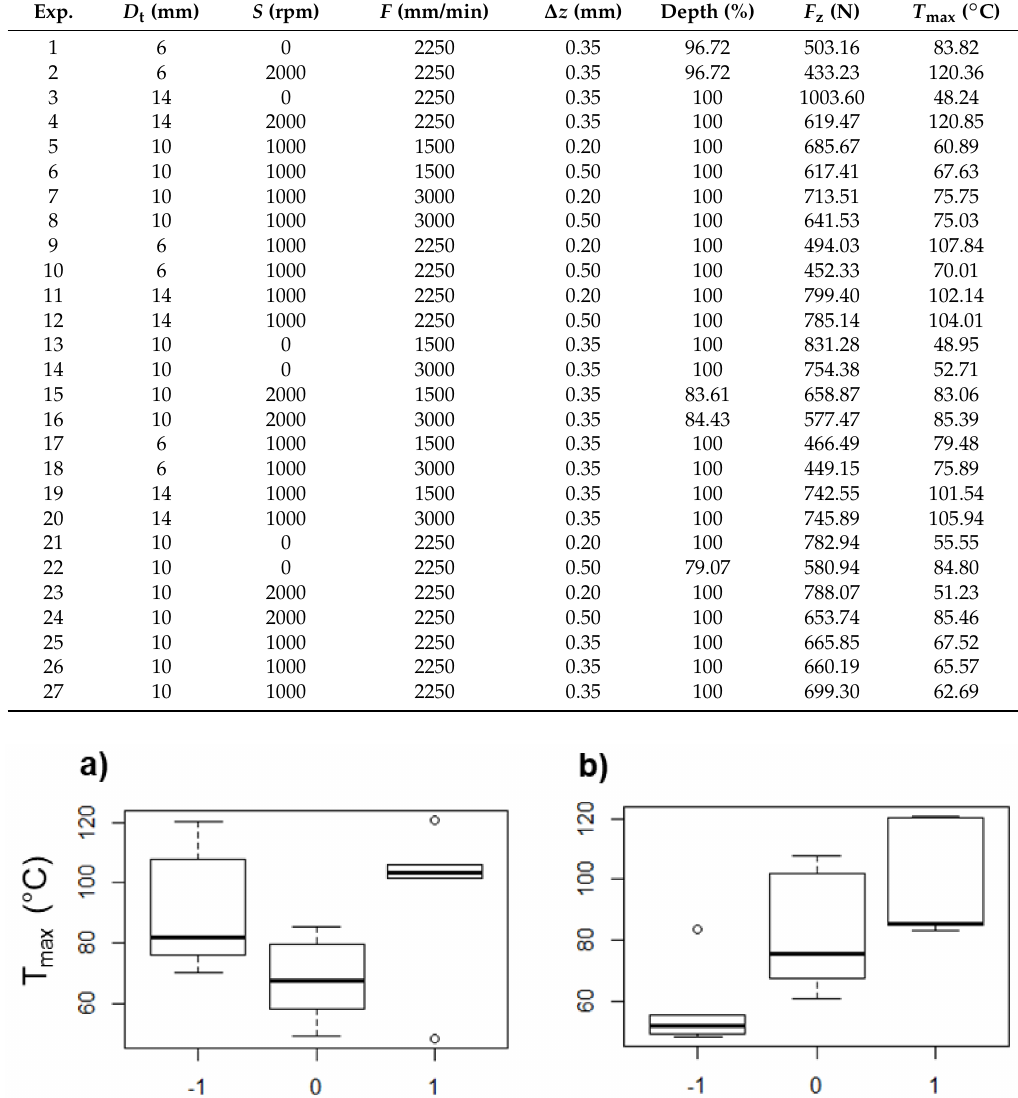
Table 6. SPIF results of UHMWPE sheets.